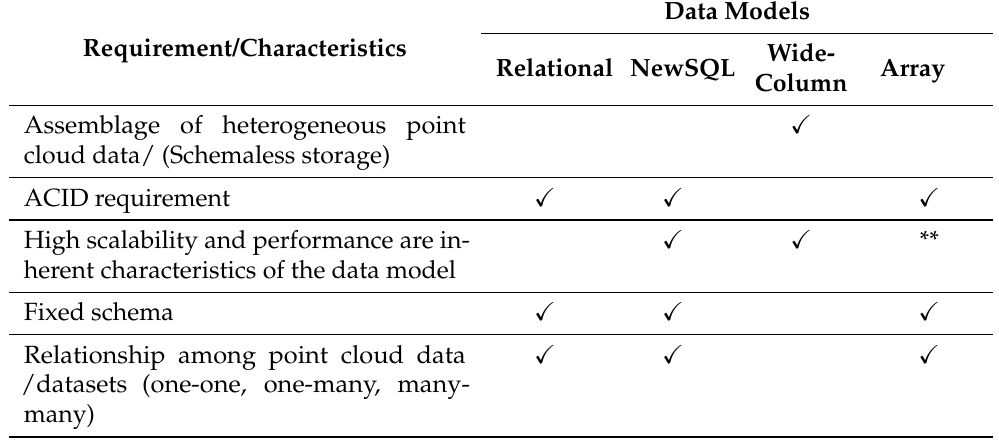
Table 5. PCDM requirements that can cater through data